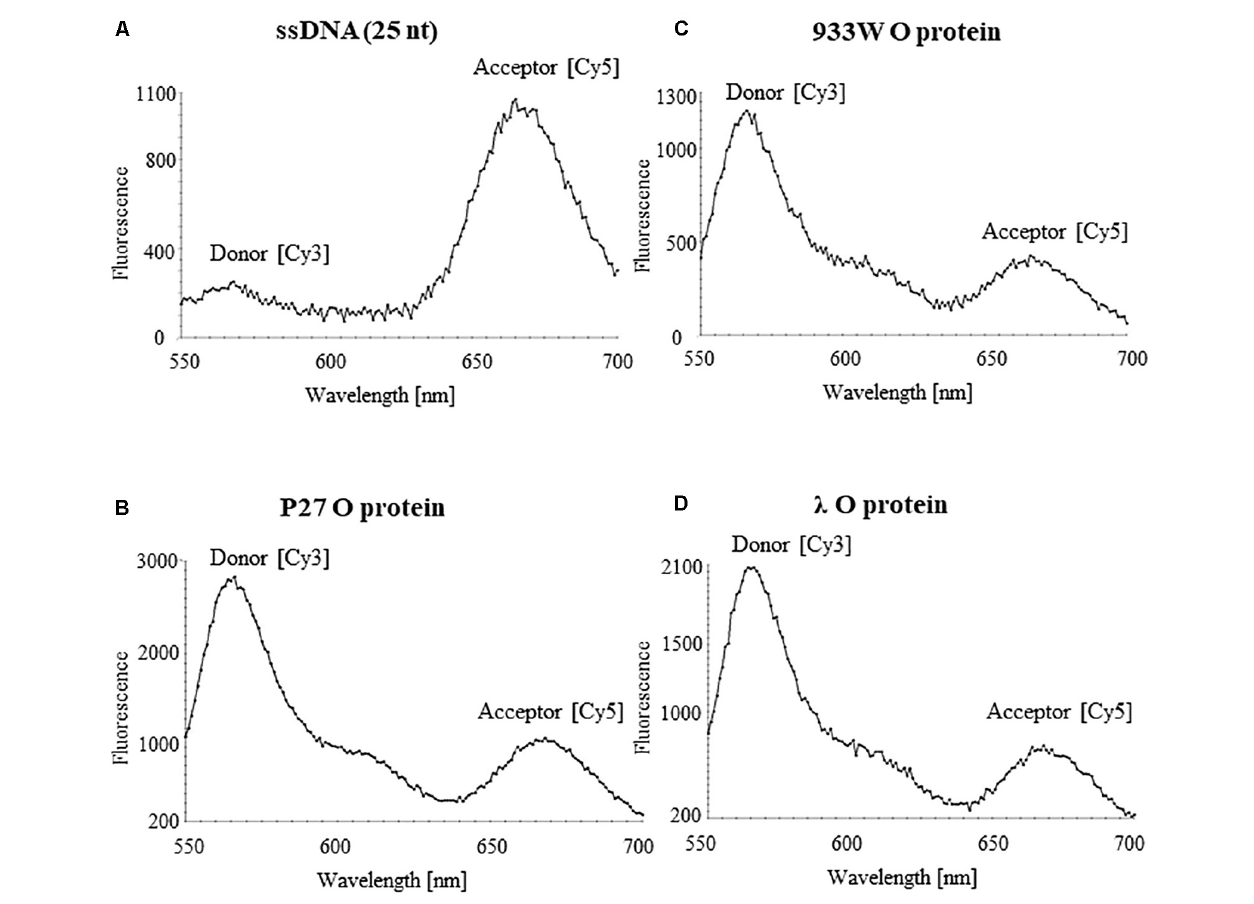
FIGURE 8 | Interactions of O proteins of phages P27 (B) , 933W (C) , and λ (D) , with ssDNA templates containing the AT-rich region as assessed by FRET. Results obtained with the sample containing only the ssDNA template are shown in (A)